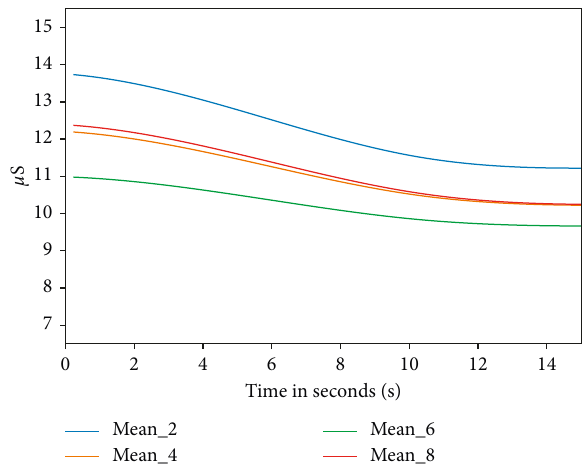
Figure 9: Plot of graphs of SCL averaged over all subjects for each density.